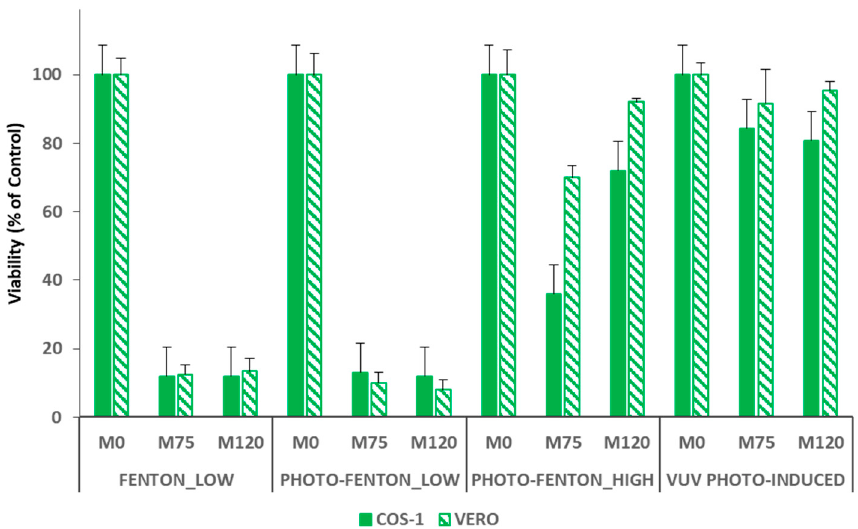
Figure 5. Results of the cytotoxicity assays performed using COS-1 (full symbols) and VERO (slashed symbols) and tested on samples taken after 0 (M0), 75 (M75) and 120 (M120) minutes of reaction.